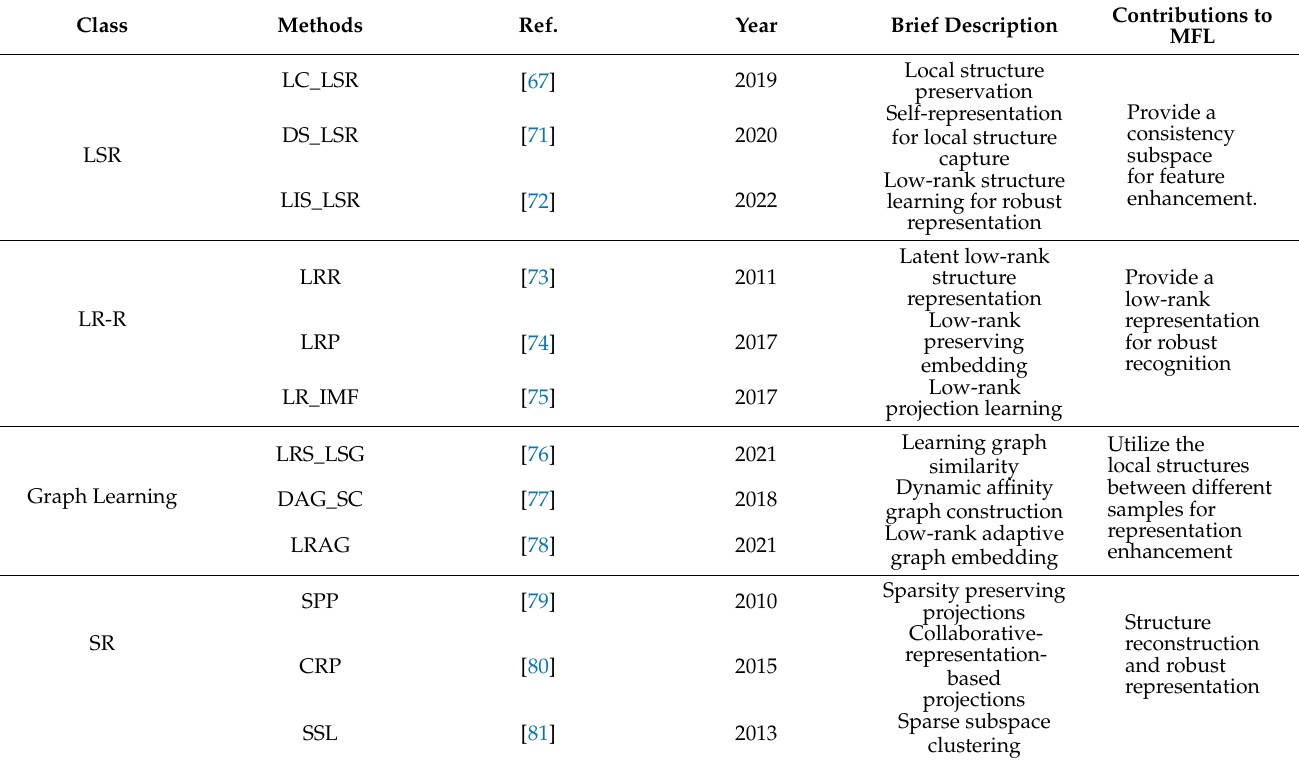
Table 4. Overview of advanced technoiques that mostly motivate the multiview learning